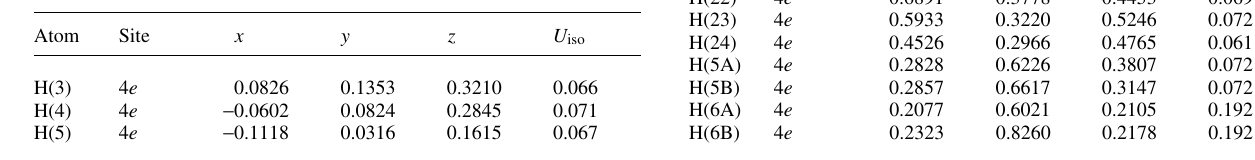
Table 2. Atomic coordinates and displacement parameters (in Å 2 ) .